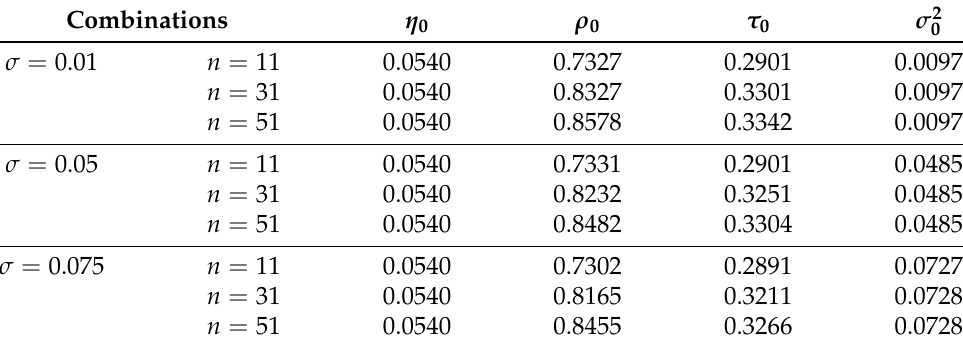
Table 2. Initial solutions for simulated data of the H 1 process.